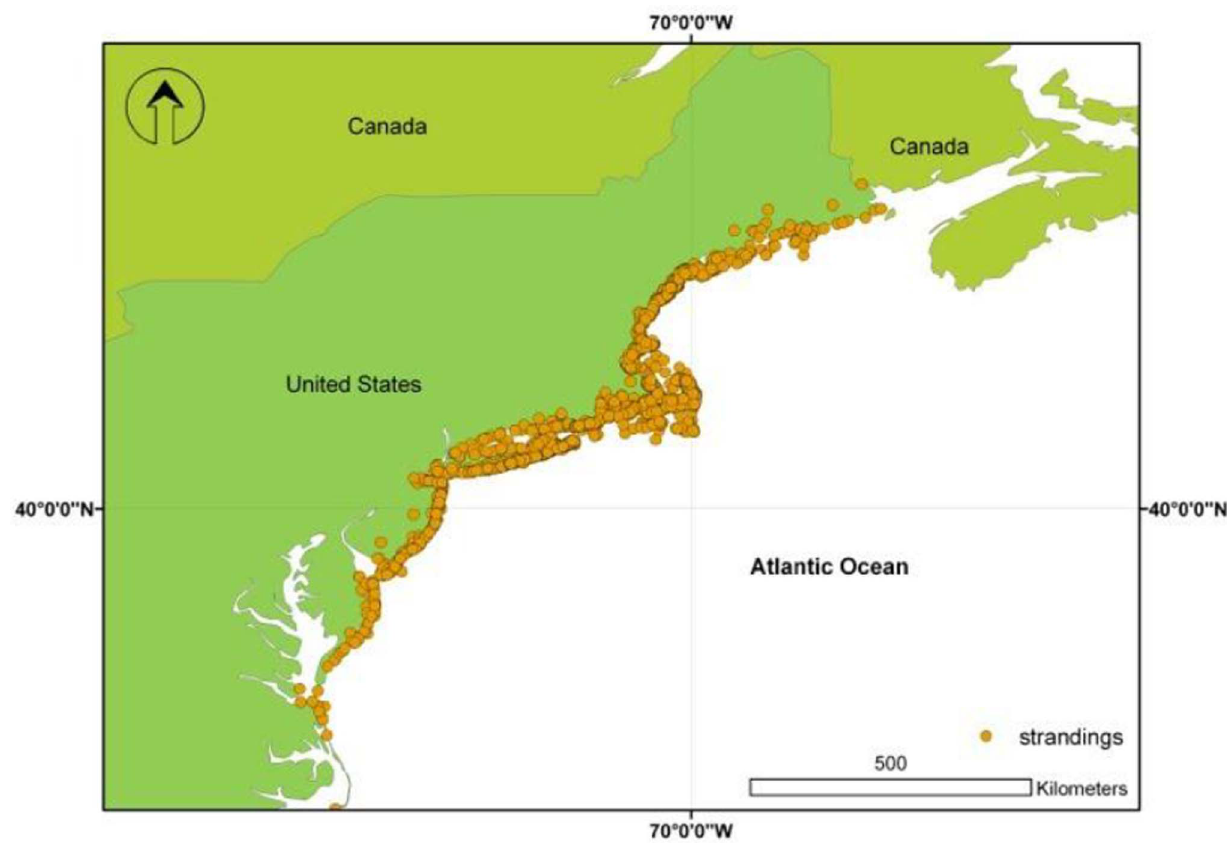
Figure 1. Harp seal strandings along the east coast of the United States: 1991–2010.